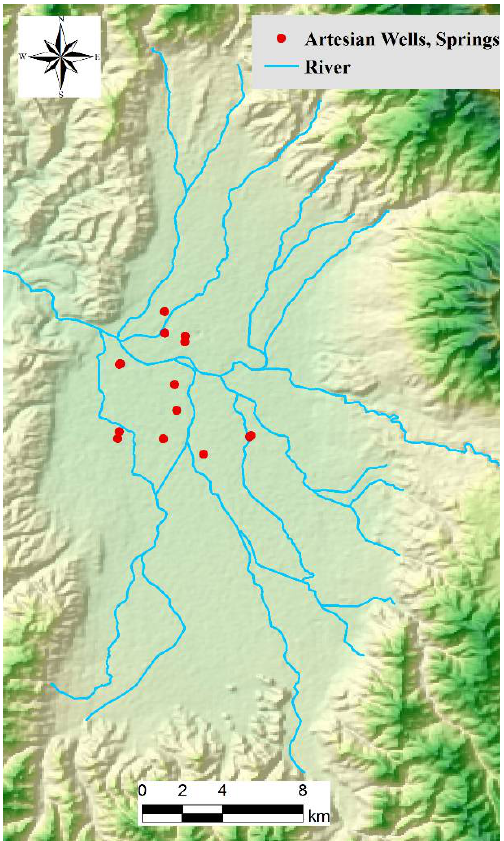
Figure 9. Distribution of existing artesian wells and springs in the Aizu Basin.